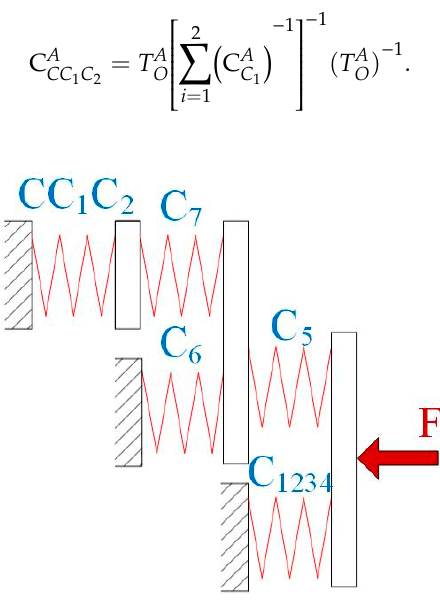
Figure 5. Sti ff ness model of the VPD with one limb Figure 5. Stiffness model of the VPD with one limb actuated.